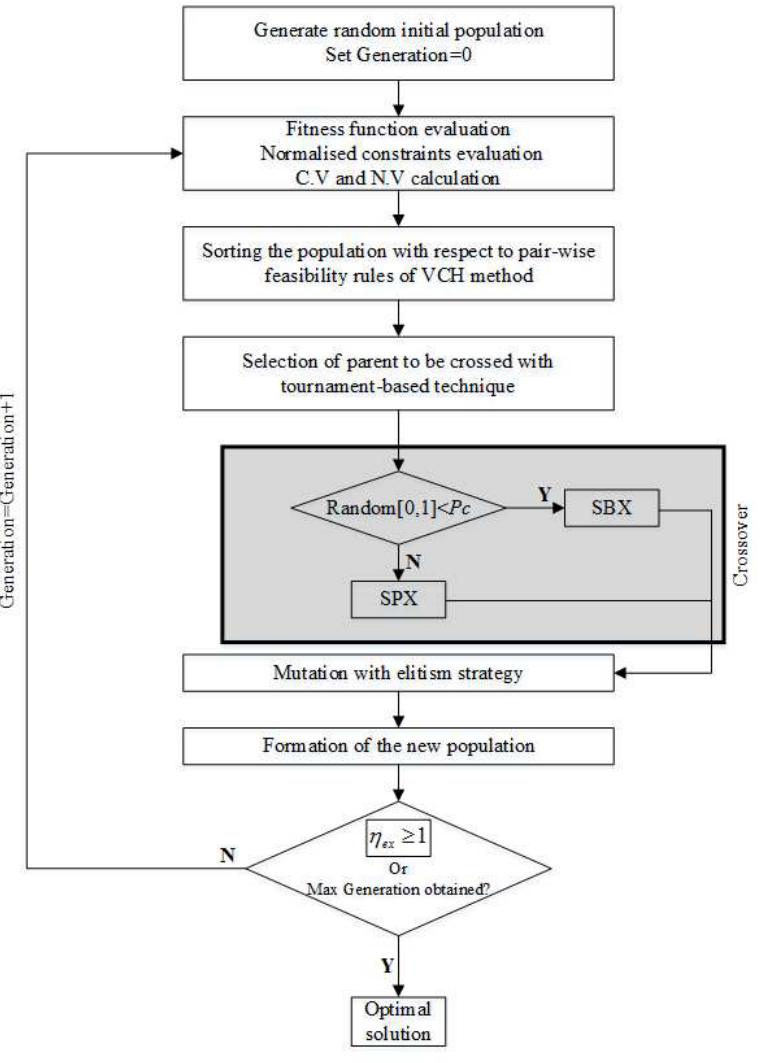
Figure 3. Proposed Real Coded Genetic Algorithm flow